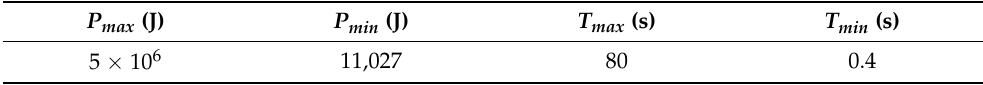
Table 3. Parameters of the cost